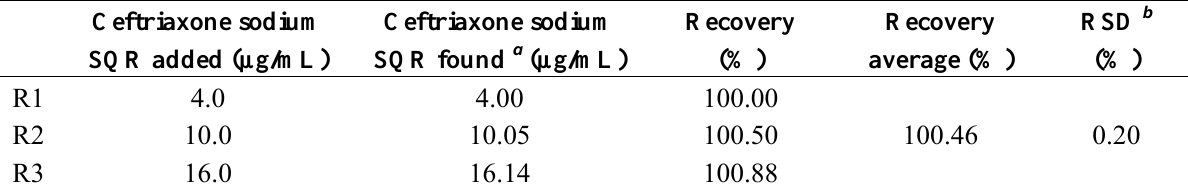
Table 2. Values obtained in the recovery test agar diffusion method for determination of ceftriaxone sodium.